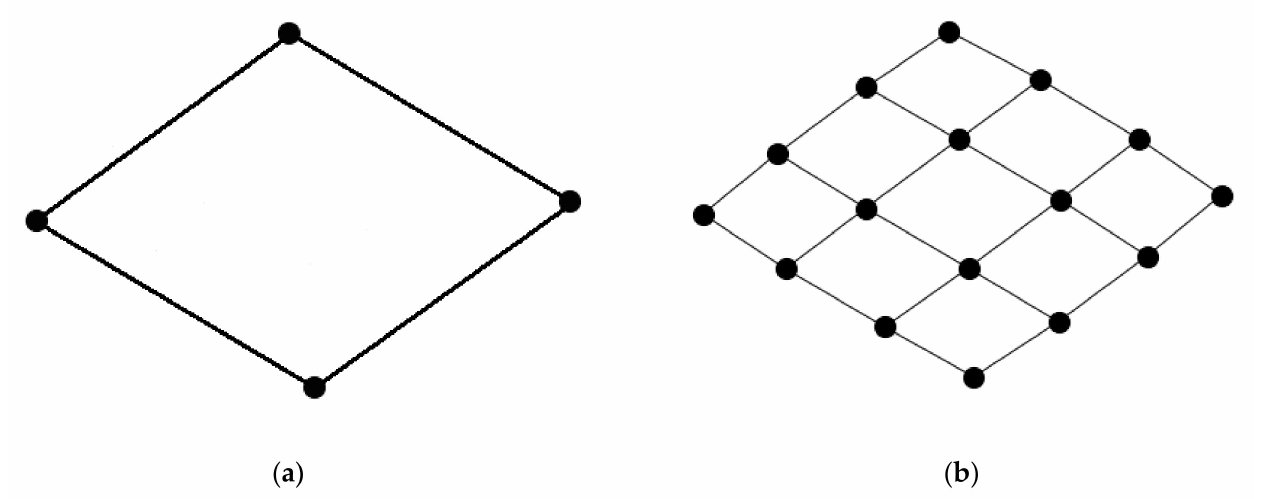
Figure 1. Images of square grid arrangements. ( a ) Single square grid defined as a cycle graph of four nodes; ( b ) a lattice-like structure that is represented by a regularly repeated pattern of square